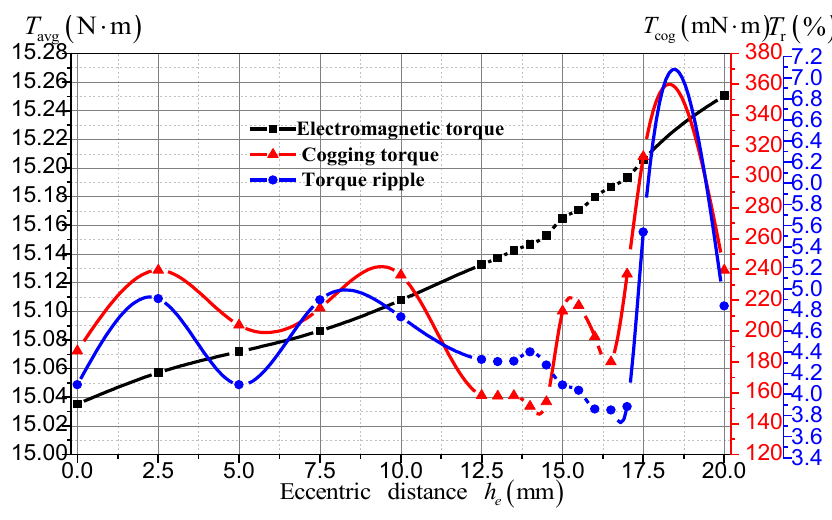
Figure 10. Average torques, torque ripples, cogging torques according to the distance of h e .